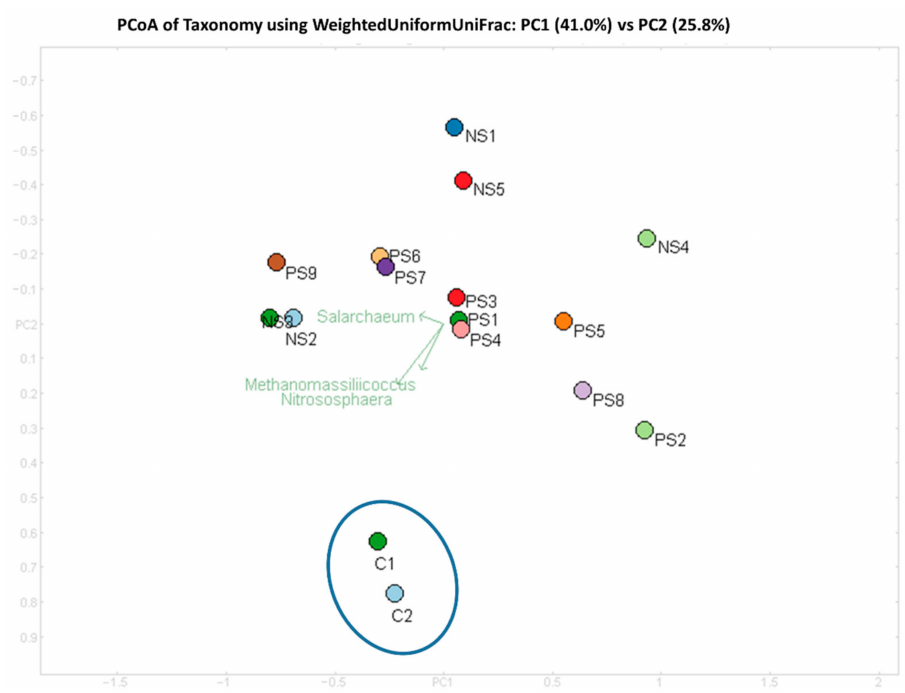
Figure 3. PCoA of samples at genus level using Weighted-Uniform-UniFrac distance. Triplot arrow represent the projection of genera for respective samples. Image was constructed in MEGAN [33].